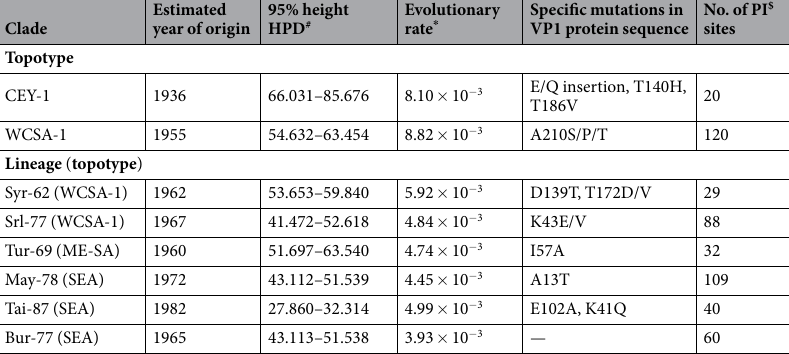
Table 1. Summary of newly identified clades (topotypes and lineages). # Highest posterior density. * Evolutionary rate is given in Substitutions per site per year. $ Parsimony informative